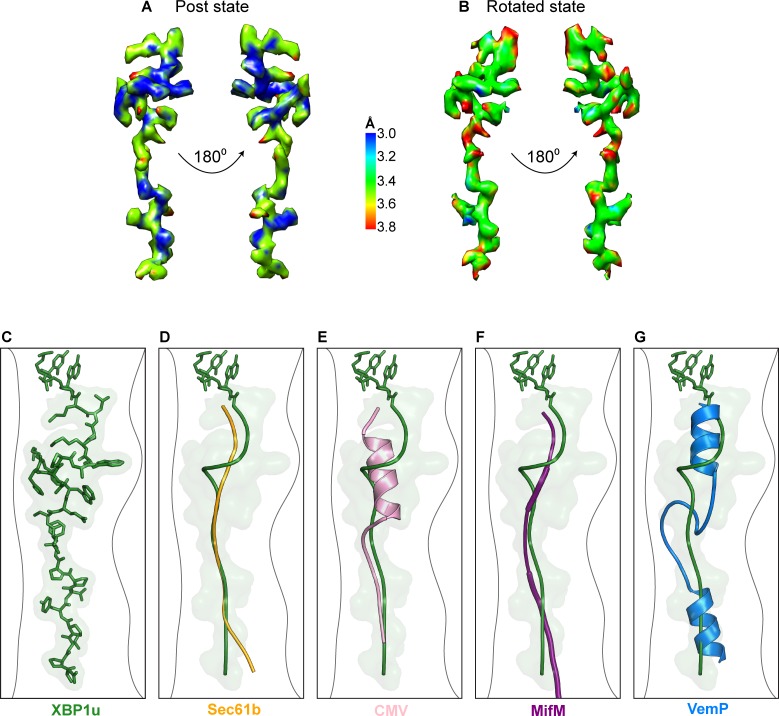
XBP1u nascent chain resolution in the ribosomal tunnel and comparison to other known stalling peptides.(A–B) Isolated XBP1u nascent chain density of the post and rotated state XBP1u-RNC colored by local resolution. Post and rotated state nascent chain densities are displayed at the contour level of 3 σ. (C–G) Superposition of XBP1u nascent chain (model in forest green, surface in light green) with Sec61b (orange, PDB ID 3JAG) (Voorhees and Hegde, 2015), hCMV (pink, PDB ID 5A8L) (Matheisl et al., 2015), MifM (purple, PDB ID 3J9W) (Sohmen et al., 2015) and VemP (blue, PDB ID 5NWY) (Su et al., 2017) respectively.